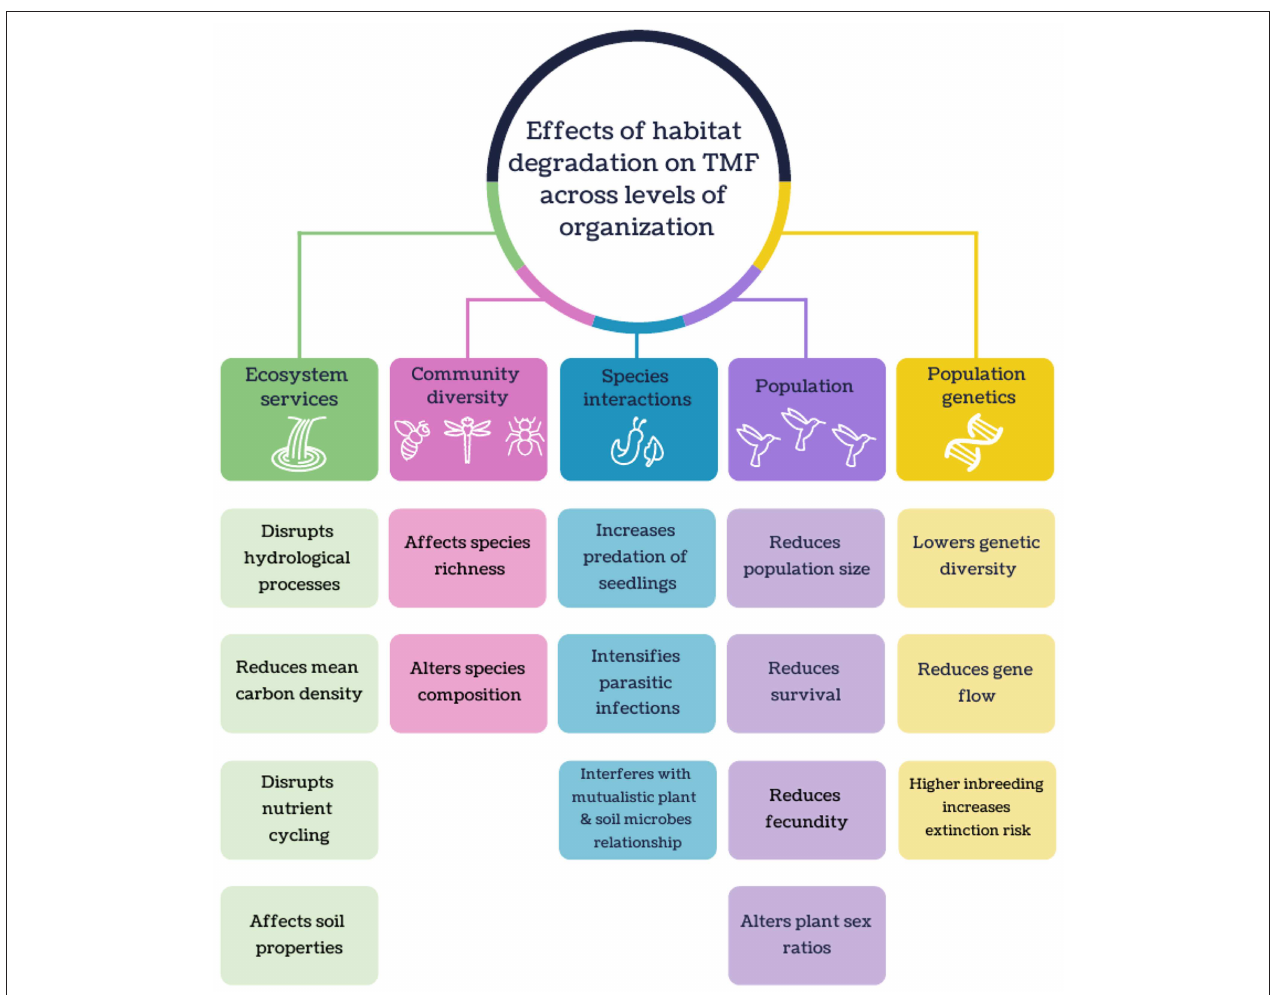
FIGURE 7 | Schematic of the major effects of habitat degradation on tropical montane forest across levels of